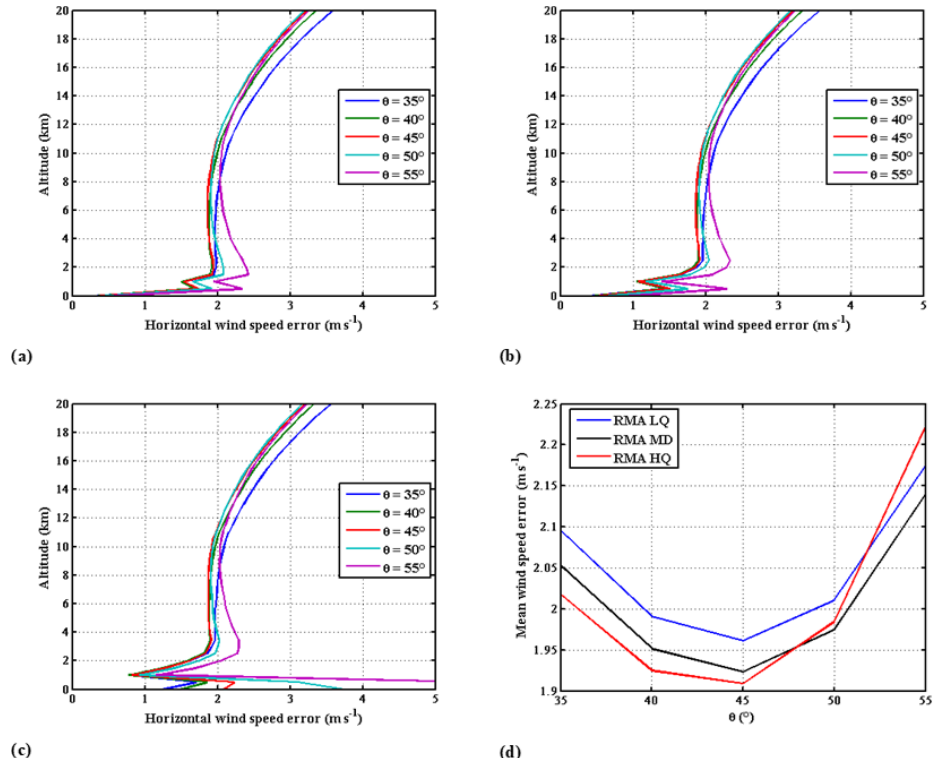
Figure 7. (a, b, c) HLOS wind speed statistical error as a function of altitude for LOS angles between 35 and 55 ◦ , for lower quartile, median, and higher quartile RMA aerosols distribution, respectively. (d) HLOS wind speed error averaged between 0.5 and 15km in altitude as a function of LOS angle.